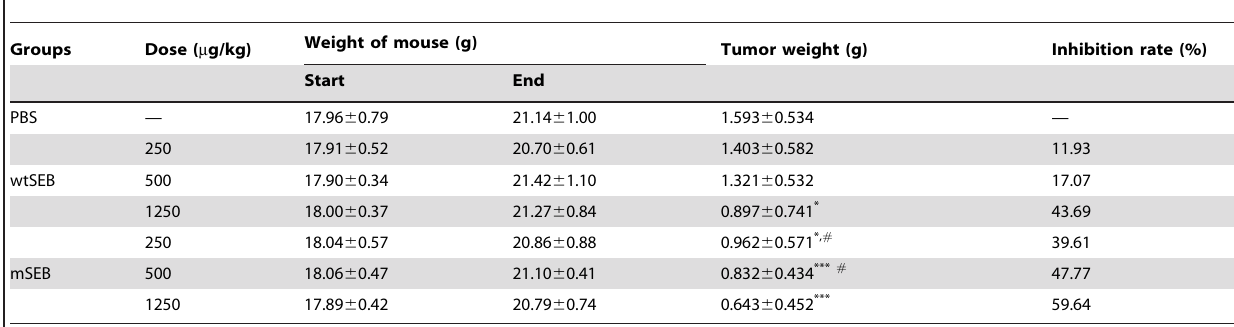
Data represent the mean 6 SD (n=10). The results shown are representative of three repeated experiments. Comparison versus PBS controls: * P , 0.05, *** P , 0.001. Comparison versus wtSEB group at the same dose: #